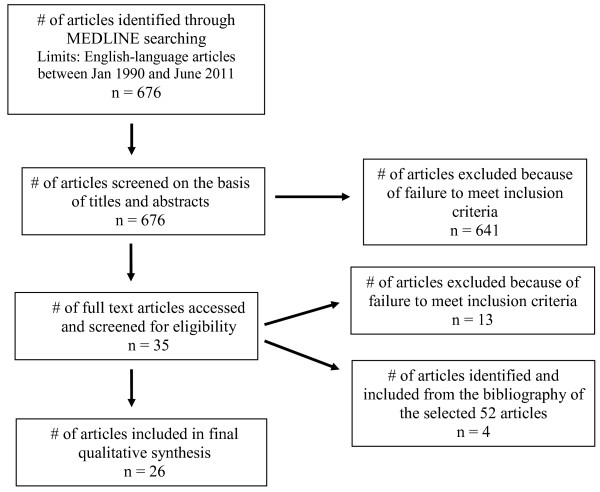
Flow-chart depicting MEDLINE search results.